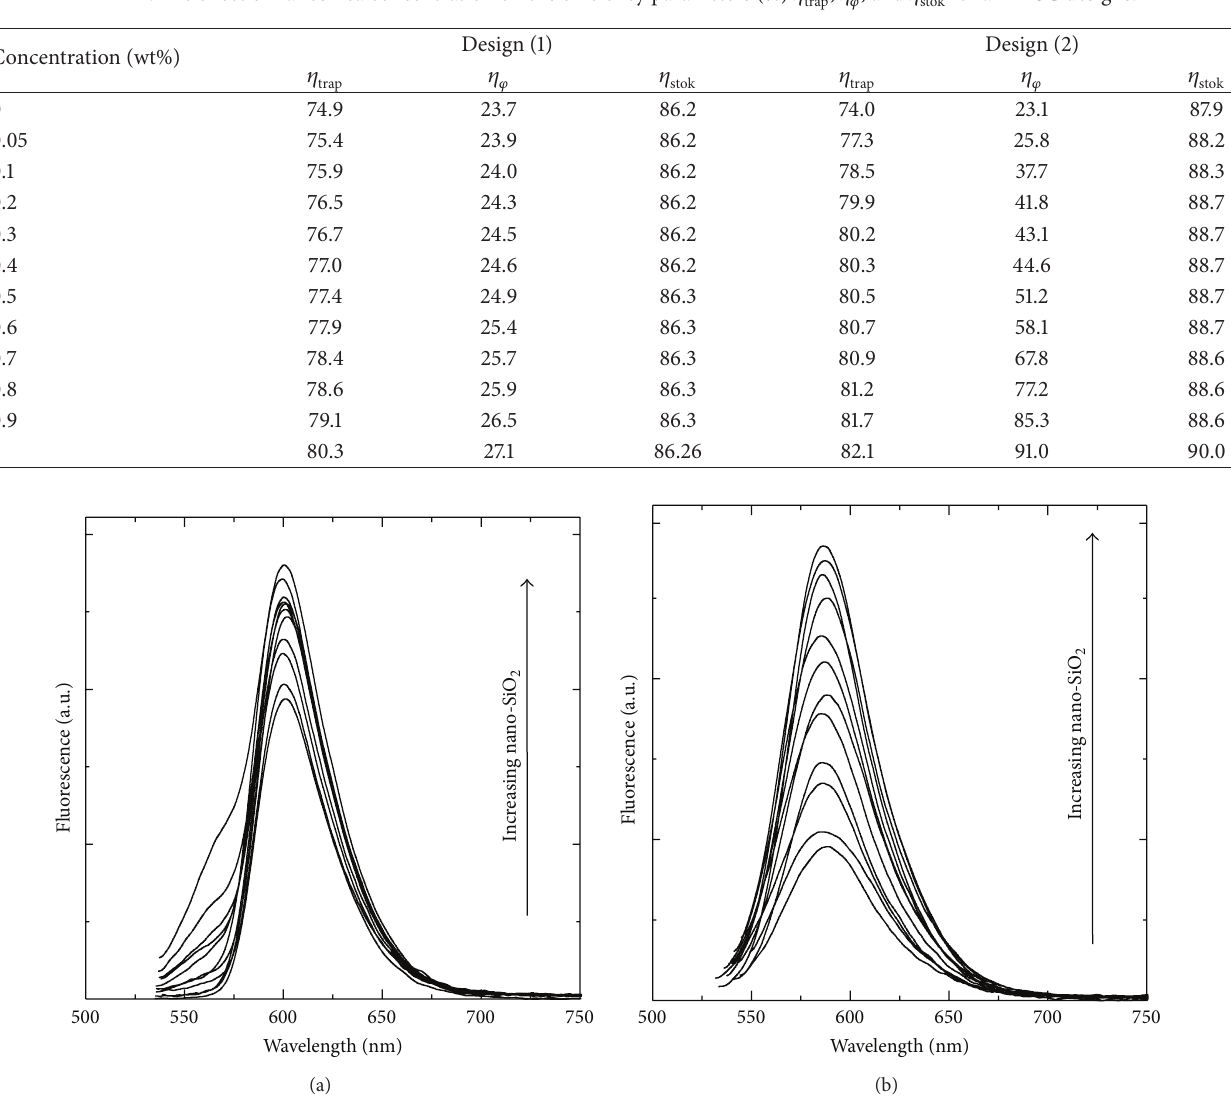
Figure 7: The effect of nanosilica concentration on the fluorescence spectra for (a) design (1) and (b) design (2)